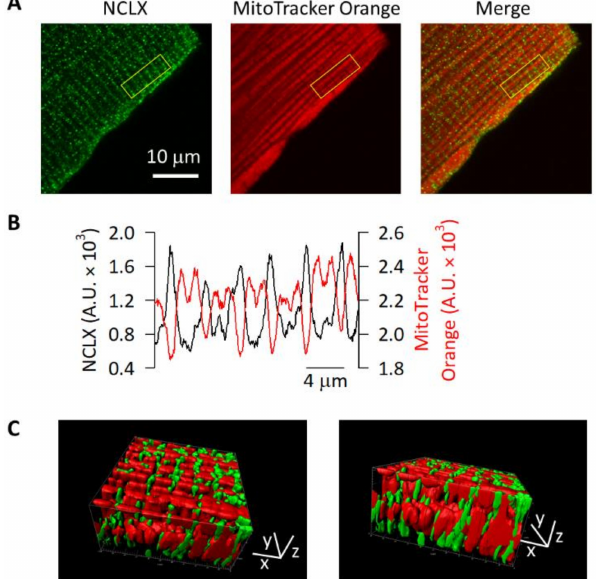
Figure 4. Immunofluorescence of NCLX in mouse ventricular myocytes. Isolated cells loaded with 1 µ M MitoTracker Orange CMTMRos were immunostained with anti-NCLX antibody. ( A ) Images of a representative cell. NCLX-derived Alexa Fluor 488 signals and MitoTracker Orange CMTMRos- derived signals are shown as green (left) and as red (middle), respectively. The merged image is shown in the right. ( B ) Column average plots of the six sarcomeres-containing regions highlighted as yellow squares in ( A ). Profiles of NCLX- and MitoTracker Orange CMTMRos-derived signals are shown as black and red lines, respectively. ( C ) The 3D-reconstructed images of another representative cell with different angles. The rectangular region with 11 µ m, 11 µ m, and 5.2 µ m for x, y, and z axis, respectively, is